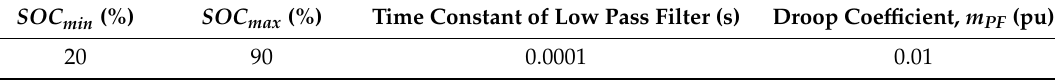
Table 2. Parameters used in Figure 1.